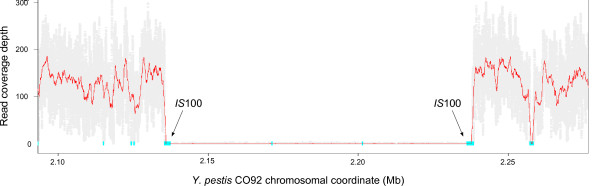
Common deletion in Y. pestis 97A-7970 and La Paz. The 102 kb deletion is depicted on the La Paz chromosome, as in Figure 1. Positions of flanking IS100 elements on the CO92 chromosome are indicated.